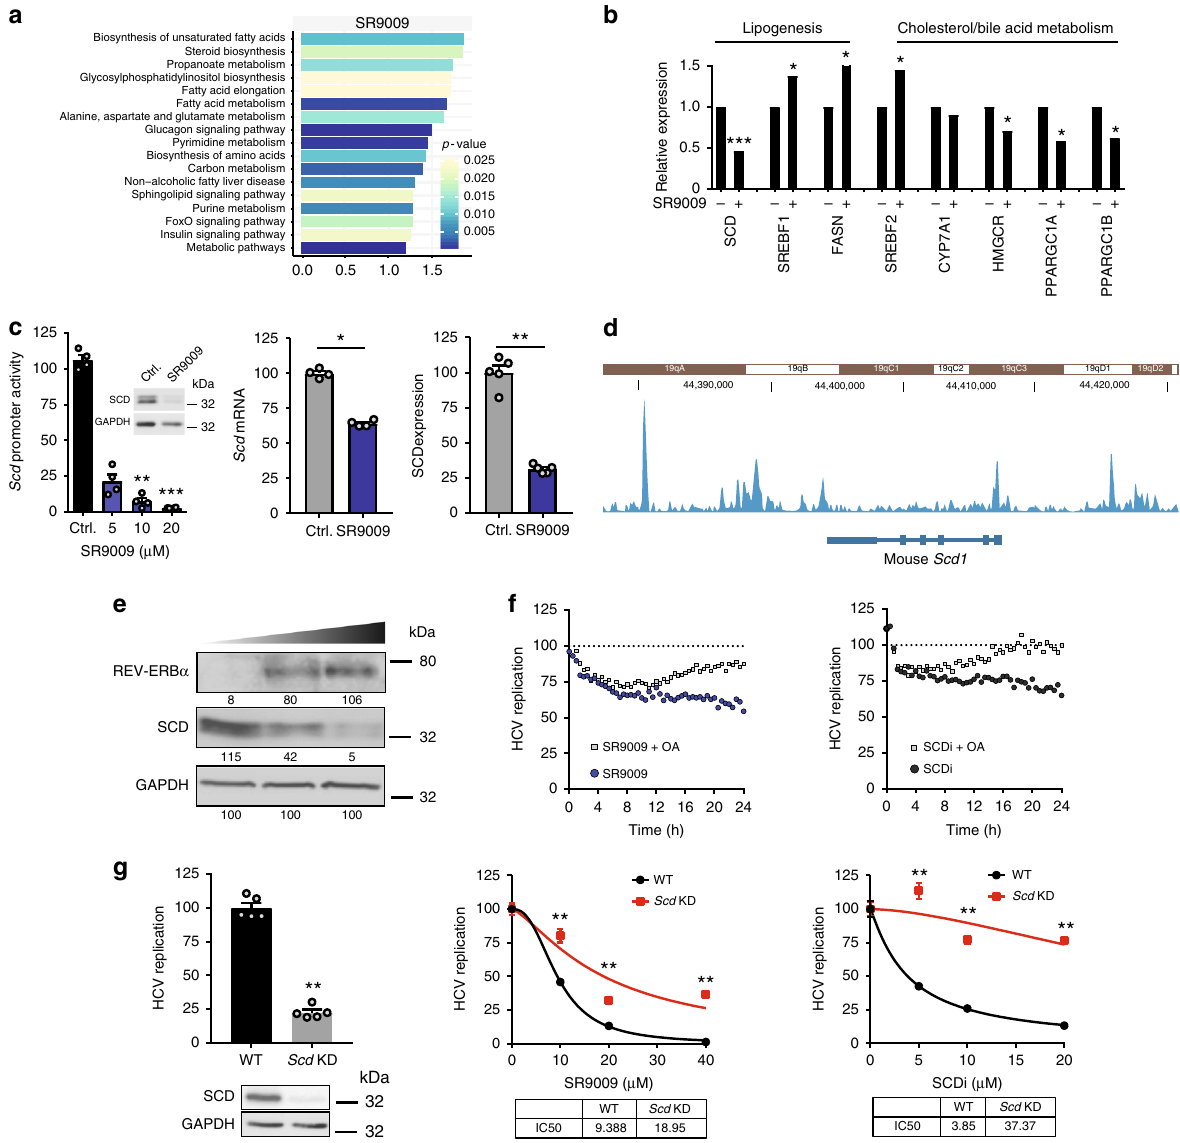
Fig. 5 REV-ERB activation perturbs fatty acid metabolism. a REV-ERB agonist SR9009 perturbs metabolic pathways. Huh-7 cells were treated with SR9009 (20 µ M) or vehicle control for 24 h and gene expression analysed by human genome microarray (biological replicates n = 3). Differentially expressed genes were assessed by KEGG pathway enrichment analysis. b Metabolic genes perturbed by SR9009. Relative expression of metabolic genes involved in lipogenesis, cholesterol and bile acid metabolism following SR9009 (20 µ M) treatment. c REV-ERB agonist inhibits SCD promoter activity and protein expression. Huh-7 cells were treated with REV-ERB agonist SR9009 (20 µ M) for 24 h and SCD promoter activity (mean ± S.E.M., n = 4, Kruskal – Wallis ANOVA with Dunn ’ s test), transcript levels and protein expression assessed by western blotting and mass spectrometric analysis. d REV-ERBs bind SCD1 promoter. Analyses of available ChIP-seq data in mouse livers 30 demonstrate REV-ERB peaks in SCD1 promoter. Read densities for REV-ERB α tracks are represented by height on the y axis. e Overexpressing REV-ERB α inhibits SCD expression. HCV A2-Luc replicon cells were transfected with an increasing dose of REV-ERB α expression plasmid. Cell lysates were collected 48 h post-transfection and assessed for SCD expression, together with housekeeping GAPDH by western blotting. f Oleic acid partially restores anti-viral activity of REV-ERB agonist SR9009. HCV replicon cells were treated with SR9009 at 15 µ M (left) or SCD inhibitor A939572 (SCDi) at 10 µ M (right) alone or in combination with oleic acid (OA) at 100 µ M. HCV RNA replication was monitored at 30 min intervals for 24 h. g A role for SCD in REV-ERB agonist inhibition of HCV replication. HCV replicon cells were transfected with CRISPRs targeting exons 2 and 3 of SCD or a scrambled guide RNA and 24 h later treated with SR9009 or SCD inhibitor A939572. SCD expression was assessed by western blotting and the dose of REV-ERB agonist or SCD inhibitor required to inhibit HCV RNA replication by 50% (IC 50 ) in control or knock- down (KD) cells determined (mean ± S.E.M., n = 5, Mann – Whitney statistical